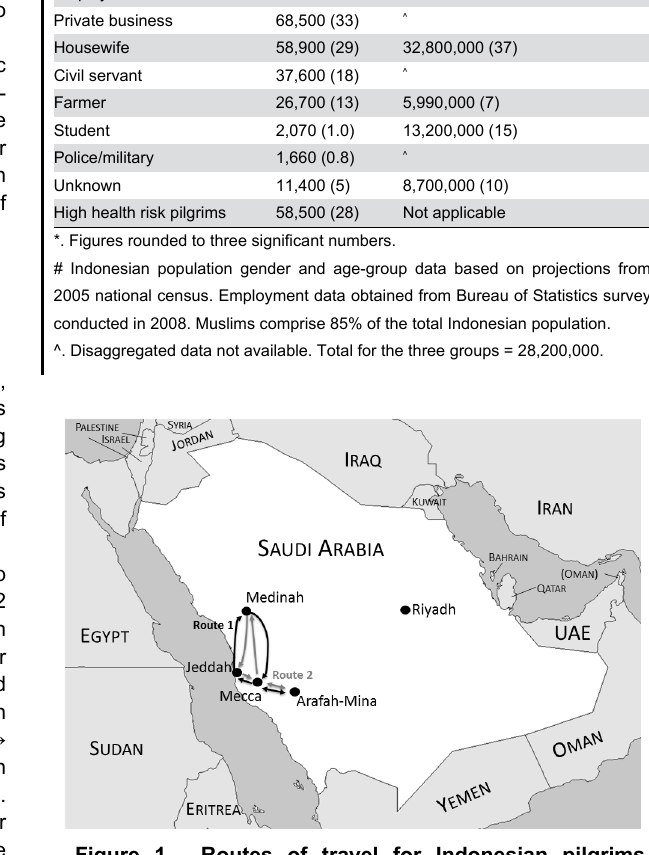
Figure 1. Routes of travel for Indonesian pilgrims, arrival in and departure from